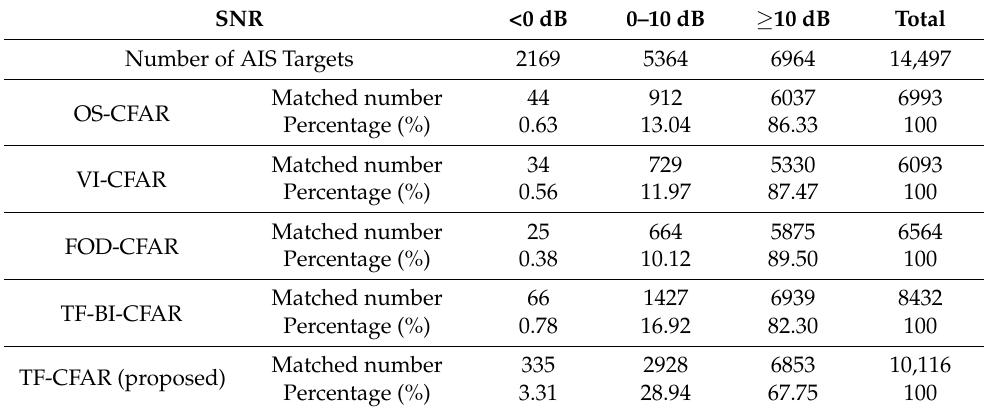
Table 7. The percentage of matched targets under different SNR on 5 October 2015. SNR <0